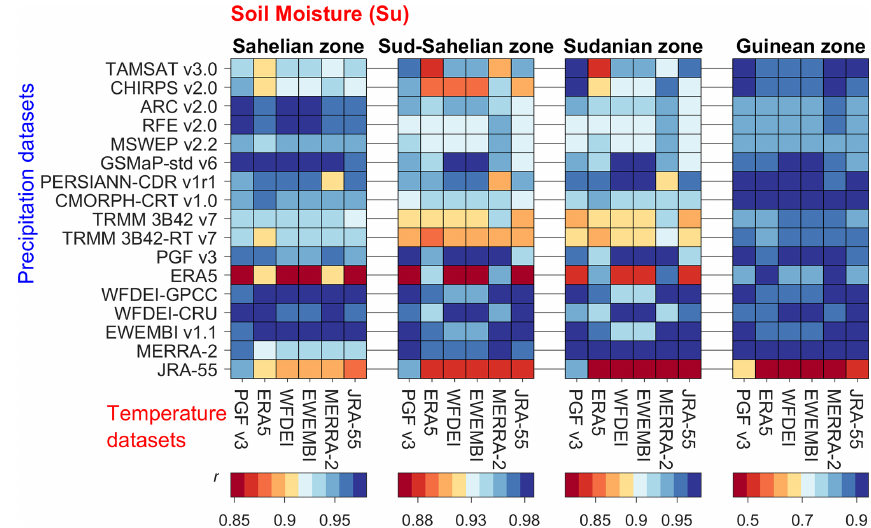
Figure 5. Pearson correlation coefficient ( r ) of modelled soil moisture ( S u ) compared to ESA CCI data over the simulation period (2003– 2012) considering 102 combinations of rainfall ( y axis) and temperature datasets (subplots on the x axis) used as forcing for the hydrological model.